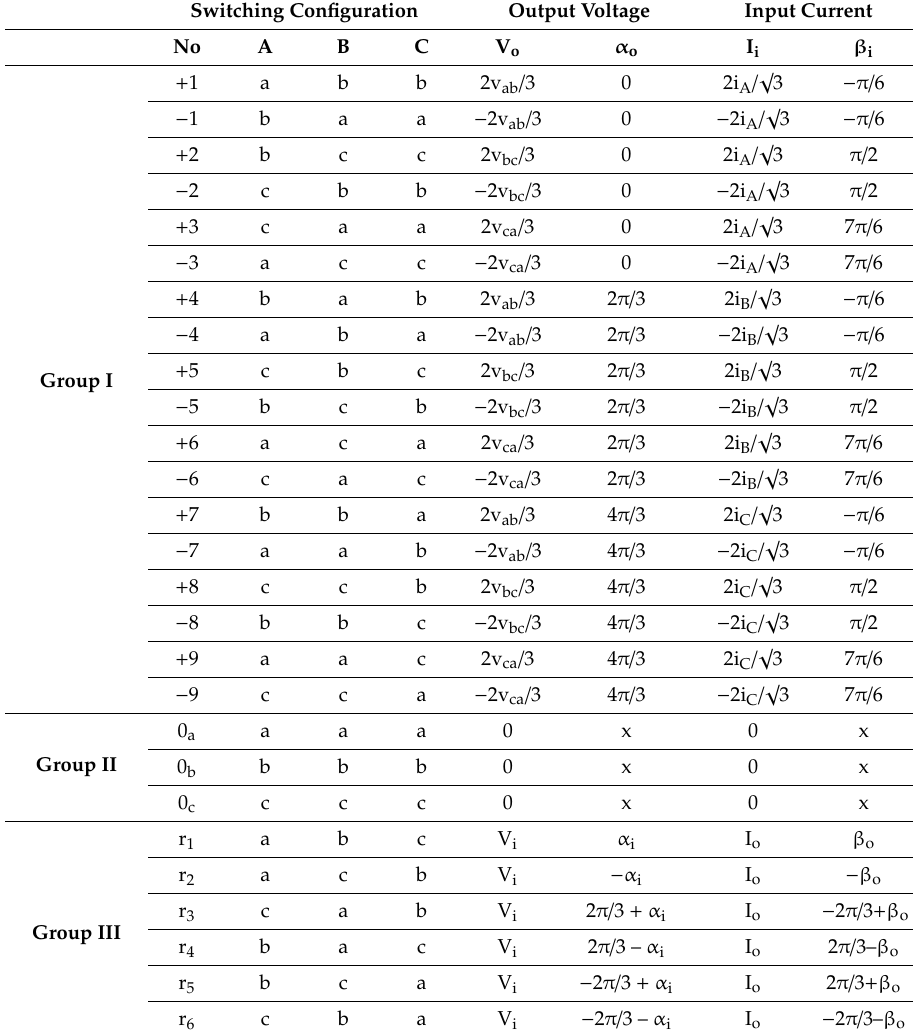
Table 1. Possible switching states in a matrix